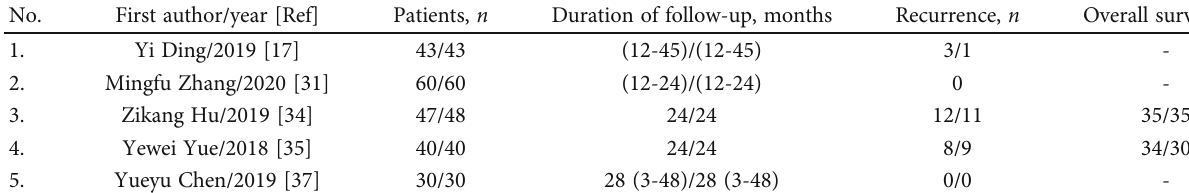
Table 6: Recurrence and overall survival of studies included in the meta-analysis.